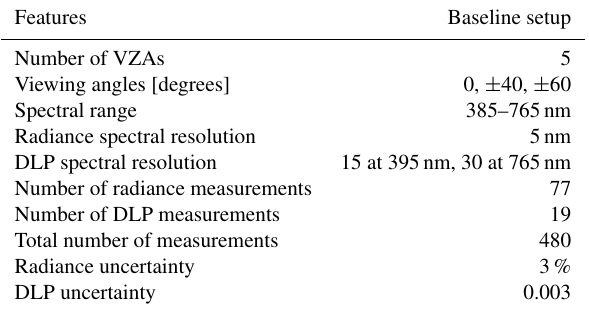
Table 7. MAP-mod baseline